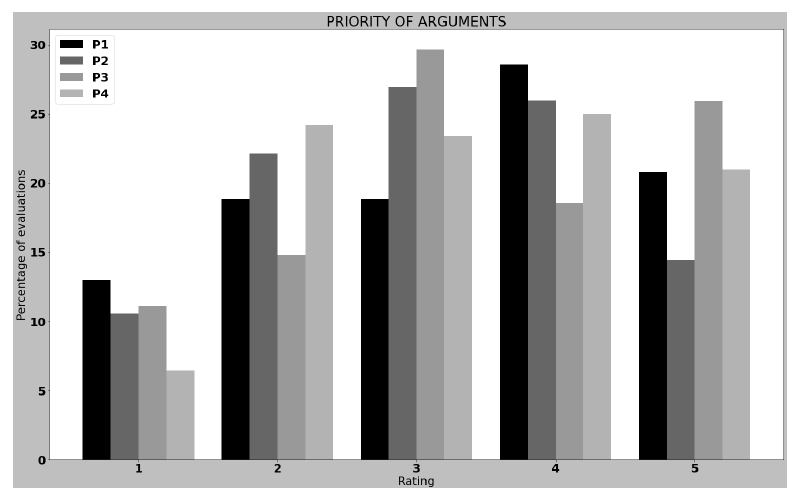
Figure 6. Histogram with the rating comparison between students for each priority ordering to show the explanations.